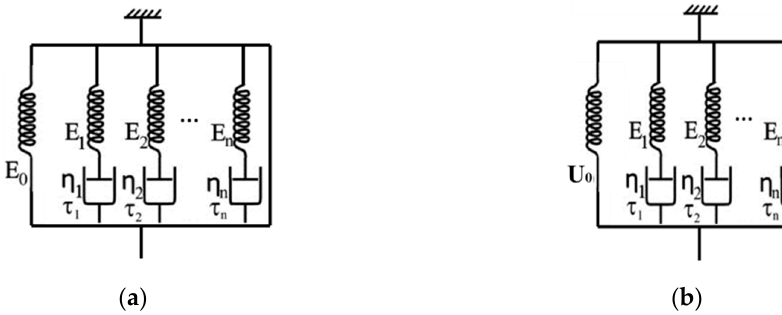
Figure 3. ( a ) Schematic of generalized Maxwell model; ( b ) Modified generalized Maxwell model.